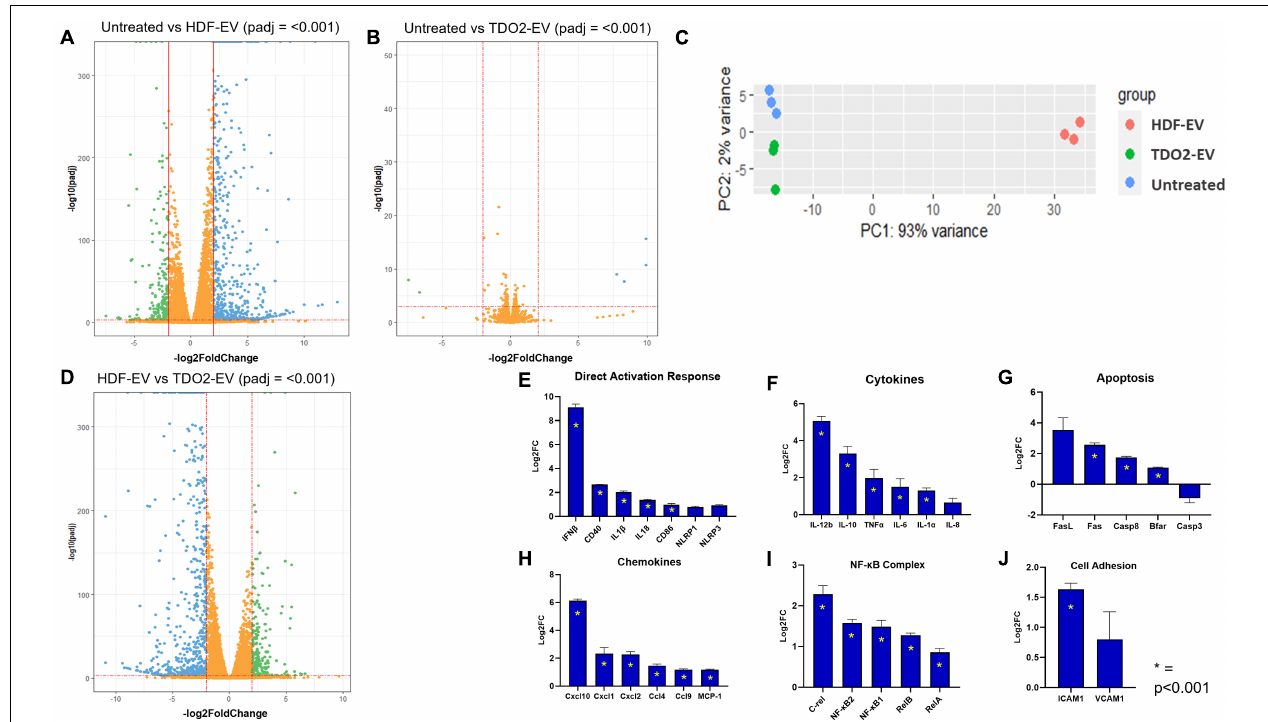
FIGURE 4 | RNA sequencing of EV-treated bone marrow-derived macrophages (BMDMs) reveals activation of inflammatory pathways by nHDF-EV. Differential expression analysis was calculated from n = 3 from two biological replicates. (A) Volcano plot visualizing the changes in gene expression in BMDM cells after treatment with nHDF-EVs compared to the untreated group. (B) Volcano plot visualizing the changes in gene expression in BMDM cells after treatment with nHDF TDO2 -EVs compared to the untreated group. (C) Principal component plot of the top 300 differentially expressed genes ( p < 0 . 001). (D) Volcano plot visualizing the changes in gene expression in BMDM cells after treatment with nHDF TDO2 -EVs compared to the nHDF-EV treated group. All volcano plots use − log10 adjusted p -values and log2 fold-changes. Genes with adjusted p -values less than 0.001 and fold-changes greater than twofold are highlighted. (E–J) Log2 fold change gene expression changes in inflammatory markers when BMDMs are treated with nHDF-EV vs nHDF TDO2 -EV. Log2FC values calculated from FPKM count values, n = 3, error bars represent standard deviation, and starred plots indicate p < 0 .